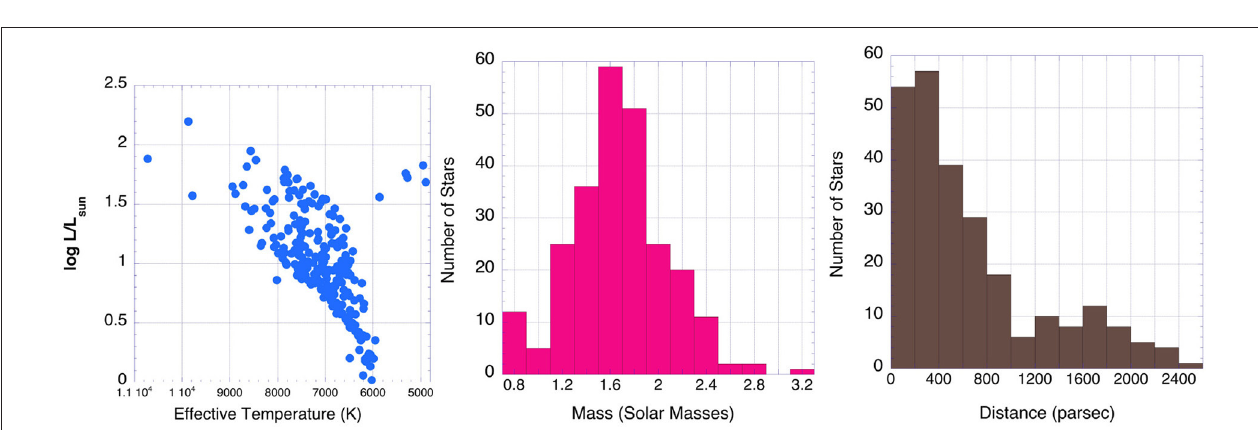
for the 249 candidate δ Sct stars. The Table also flags the stars showing more than one low-frequency ( < 5 c/d) mode that are hybrid